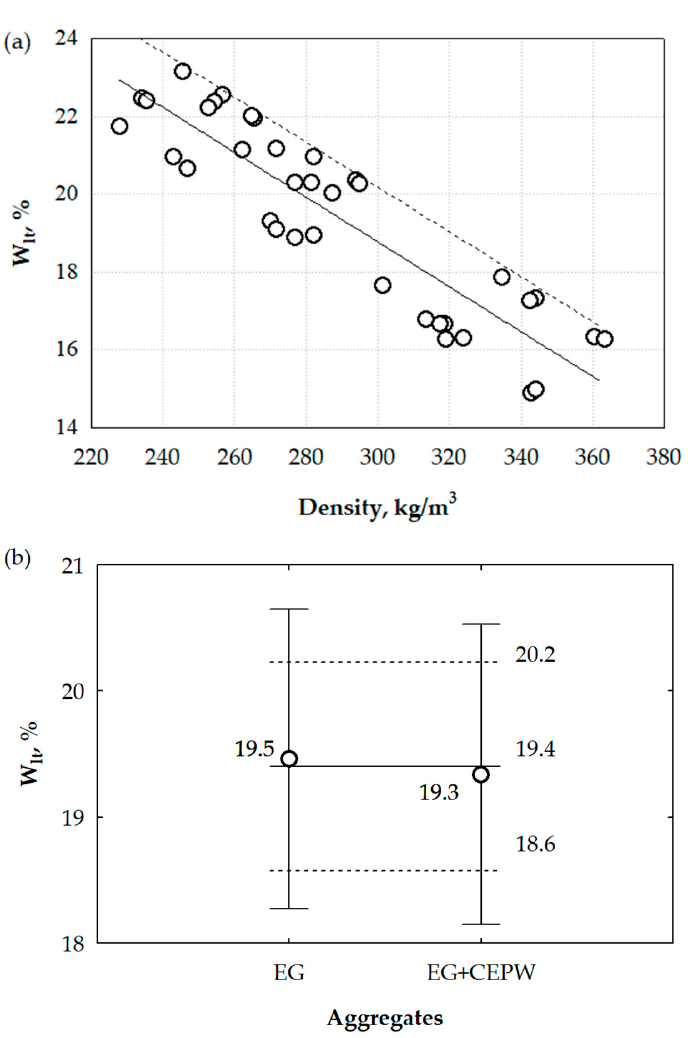
Figure 6. Dependence of the long-term water absorption of the specimens on the density ( a ) and analysis of the effect of CEPW on the water absorption ( b ).